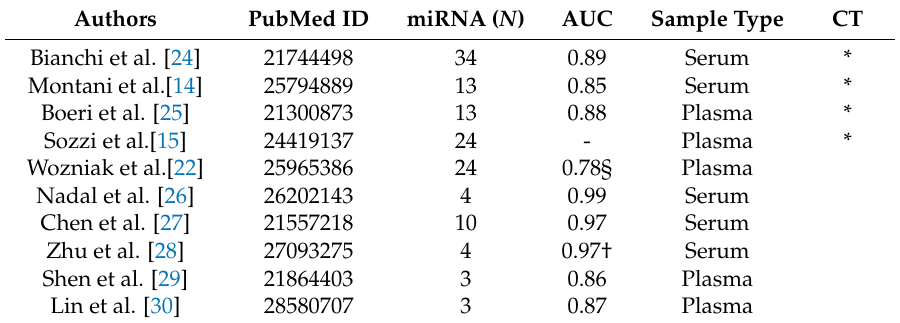
Figure 1. Schematic representation of an integrated analysis of circulating biomarkers (liquid biopsy) and radiomics, to improve lung cancer early diagnosis in at-risk individuals (defined by epidemiological risk models).